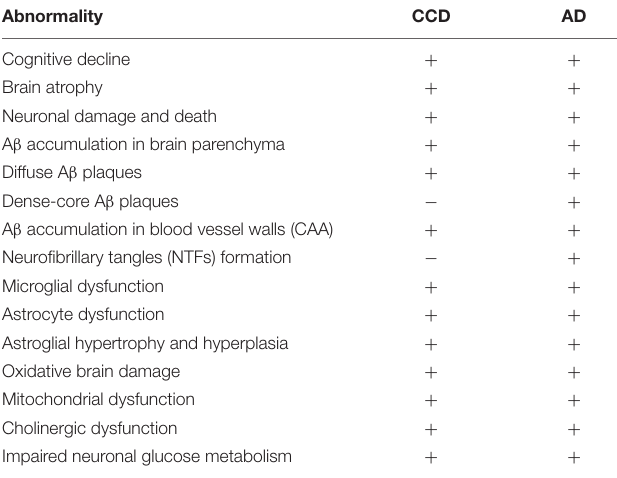
TABLE 2 | Pathological hallmarks of CCD and/or